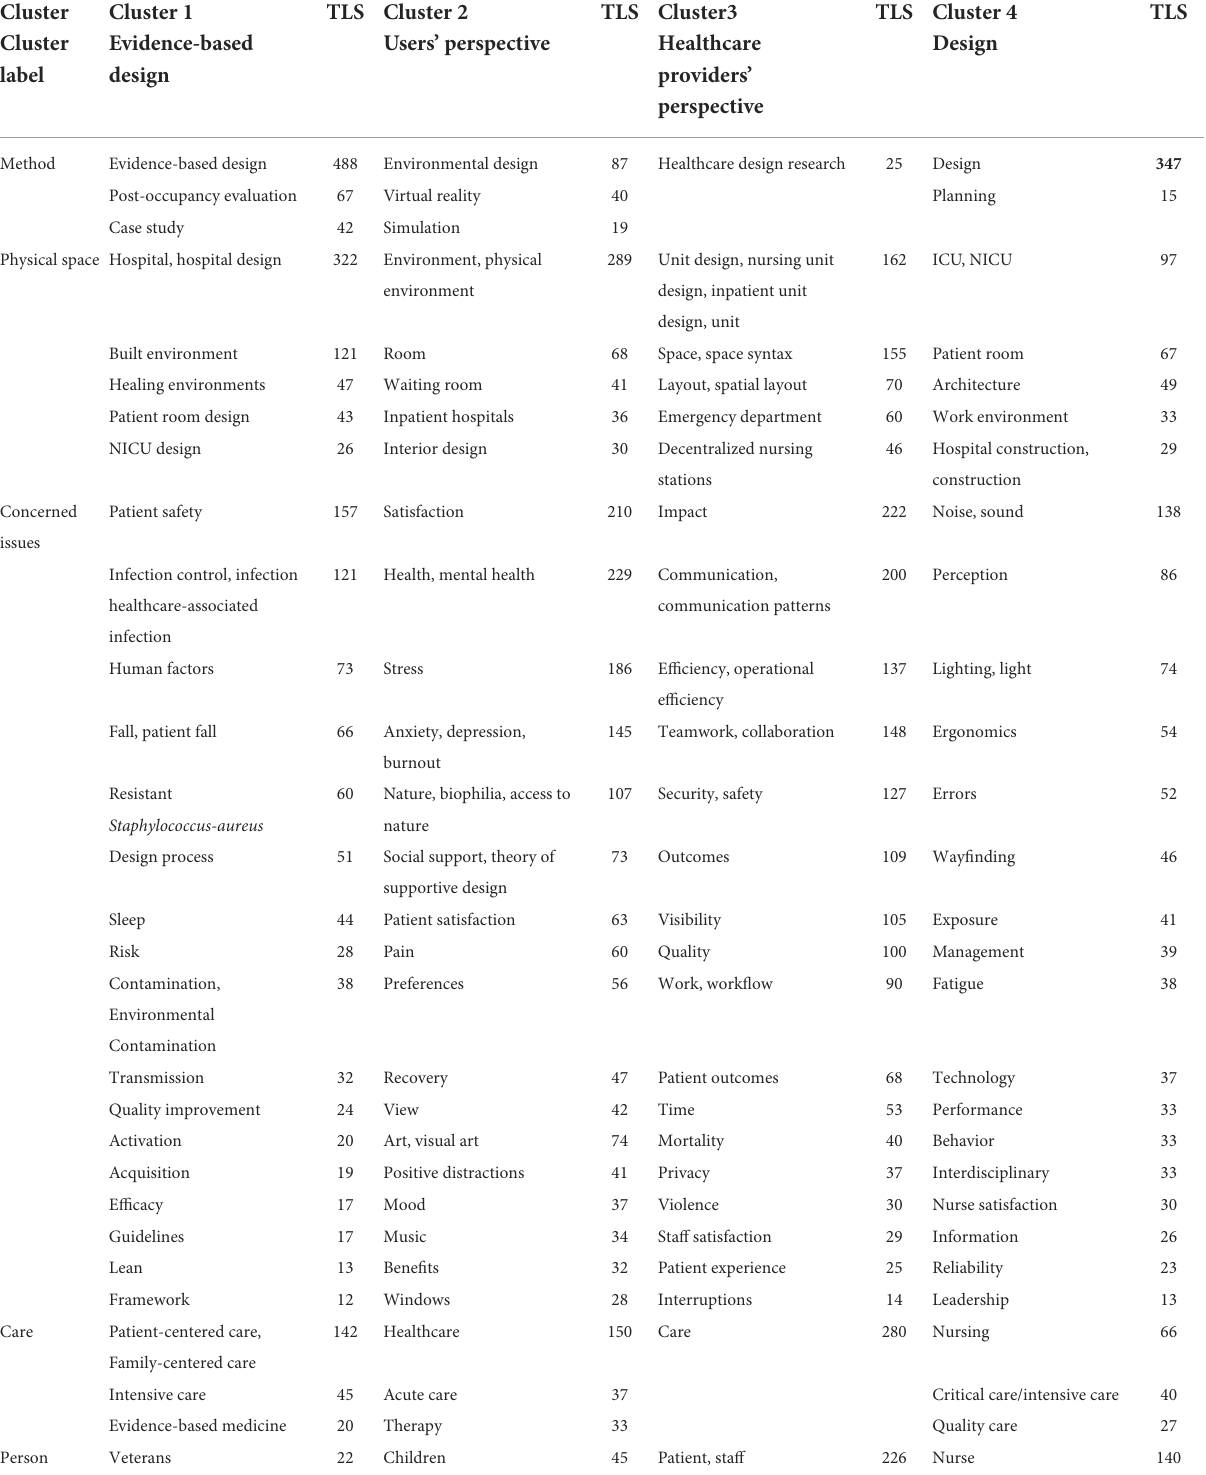
TABLE 2 Cluster analysis of keywords in the articles selected from HERD. Cluster Cluster 1 TLS Cluster 2 TLS Cluster3 TLS Cluster 4 TLS Cluster Evidence-based Users’ perspective Healthcare label design providers’ perspective